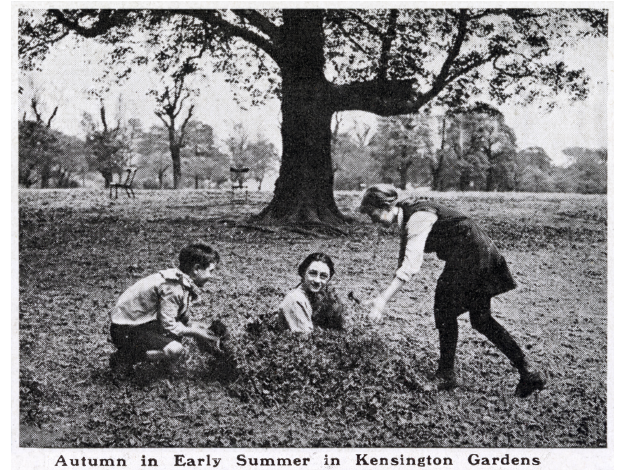
Figure A1. Photograph from the British illustrated newspaper The Sphere , 30 July 1921. The original caption is “Autumn in Early Summer in Kensington Gardens”. Copyright: Illustrated London News Ltd/Mary Evans.